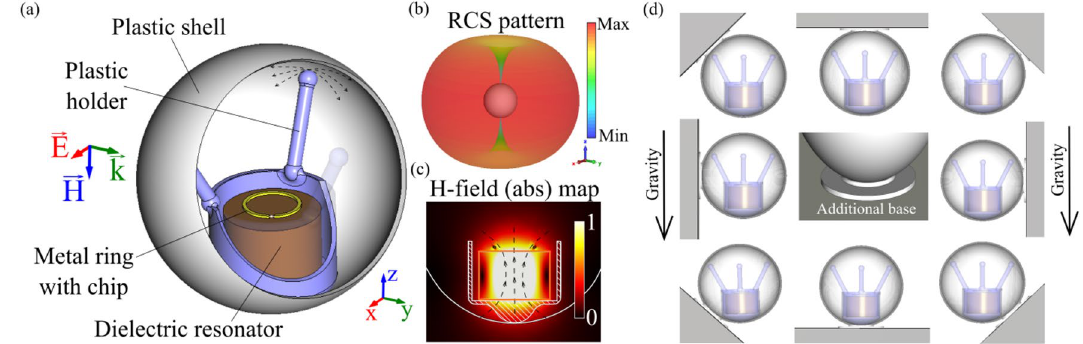
Figure 1. ( a ) Roly-poly RFID tag. ( b ) 3D radiation pattern of the tag, alighted parallel to the ground. ( c ) The magnetic field amplitude distribution at the cut plane along the cylinder’s axis. The arrows show the H-field direction. ( d ) Mechanical operational principle. The tag is attached to a surface (grey polygons) with a sticker. Regardless the orientation of the surface, the tag is self-alighted parallel to the